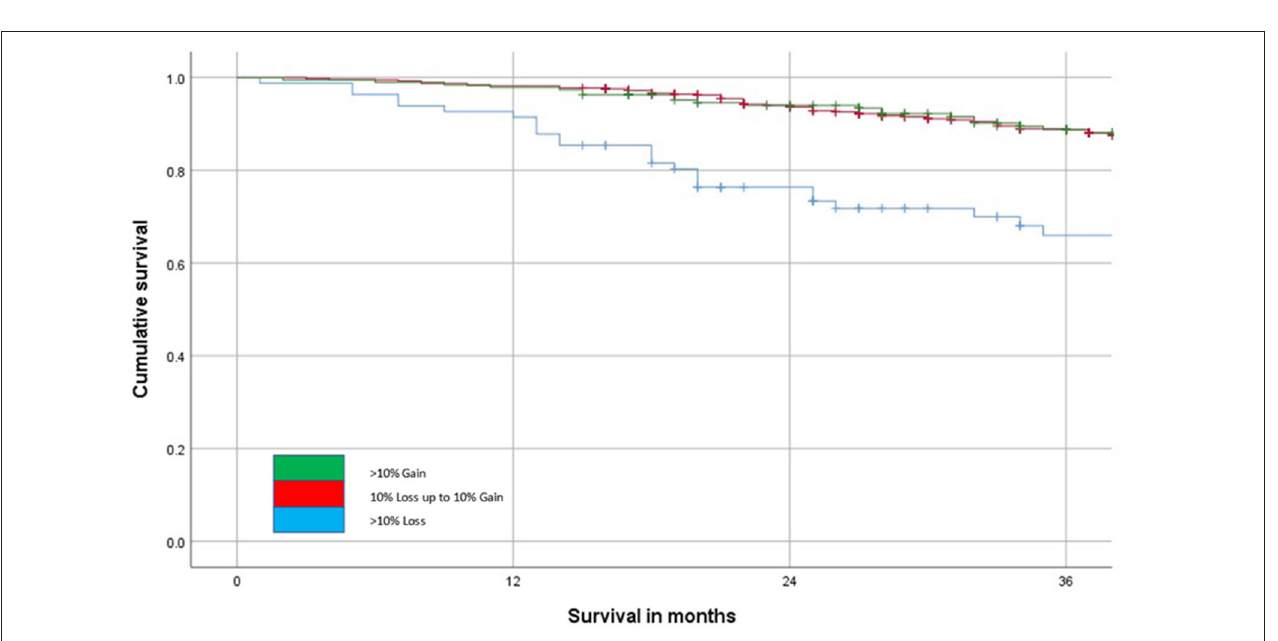
On linear regression analysis against baseline clinicopathological characteristic only mGPS ( r = 0.658, p = 0.042) and NLR ( r = 0.524, p = 0.084) were